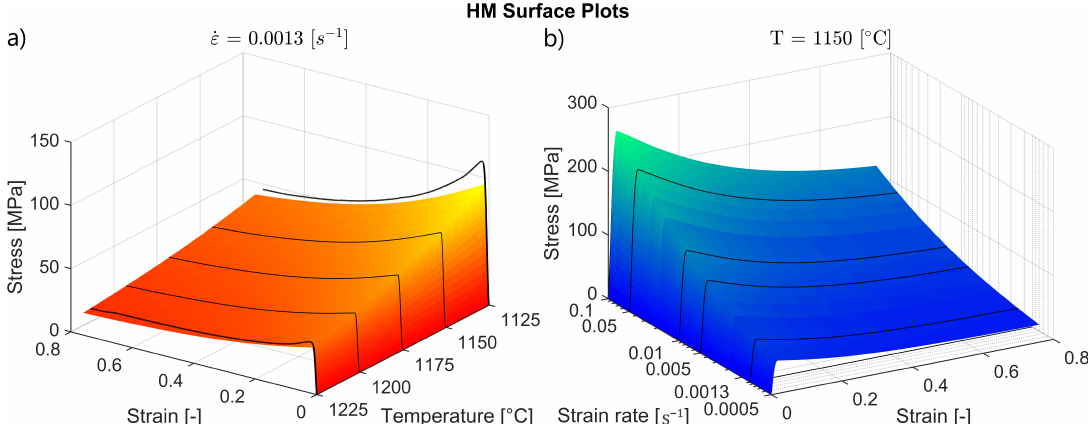
Figure 14. Surface plots of stress values predicted by the HM for interpolated and extrapolated inputs; ( a ) temperatures between 1125 and 1225 ◦ C with an increment of 5 ◦ C, ( b ) strain rates between 0.0005 and 0.1 s –1 with 10 increments between each